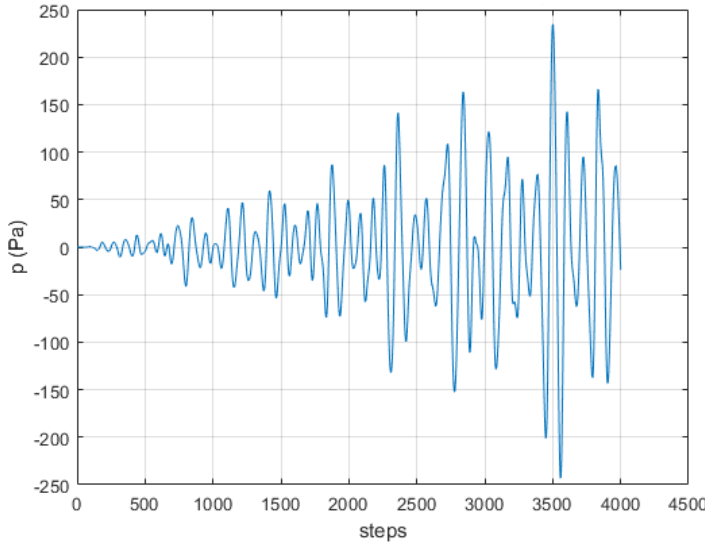
Figure 11. Pressure time history at the middle point of the 2nd segment of the horizontal beam. This segment’s Young modulus is 10 times smaller compared to the values of the remaining